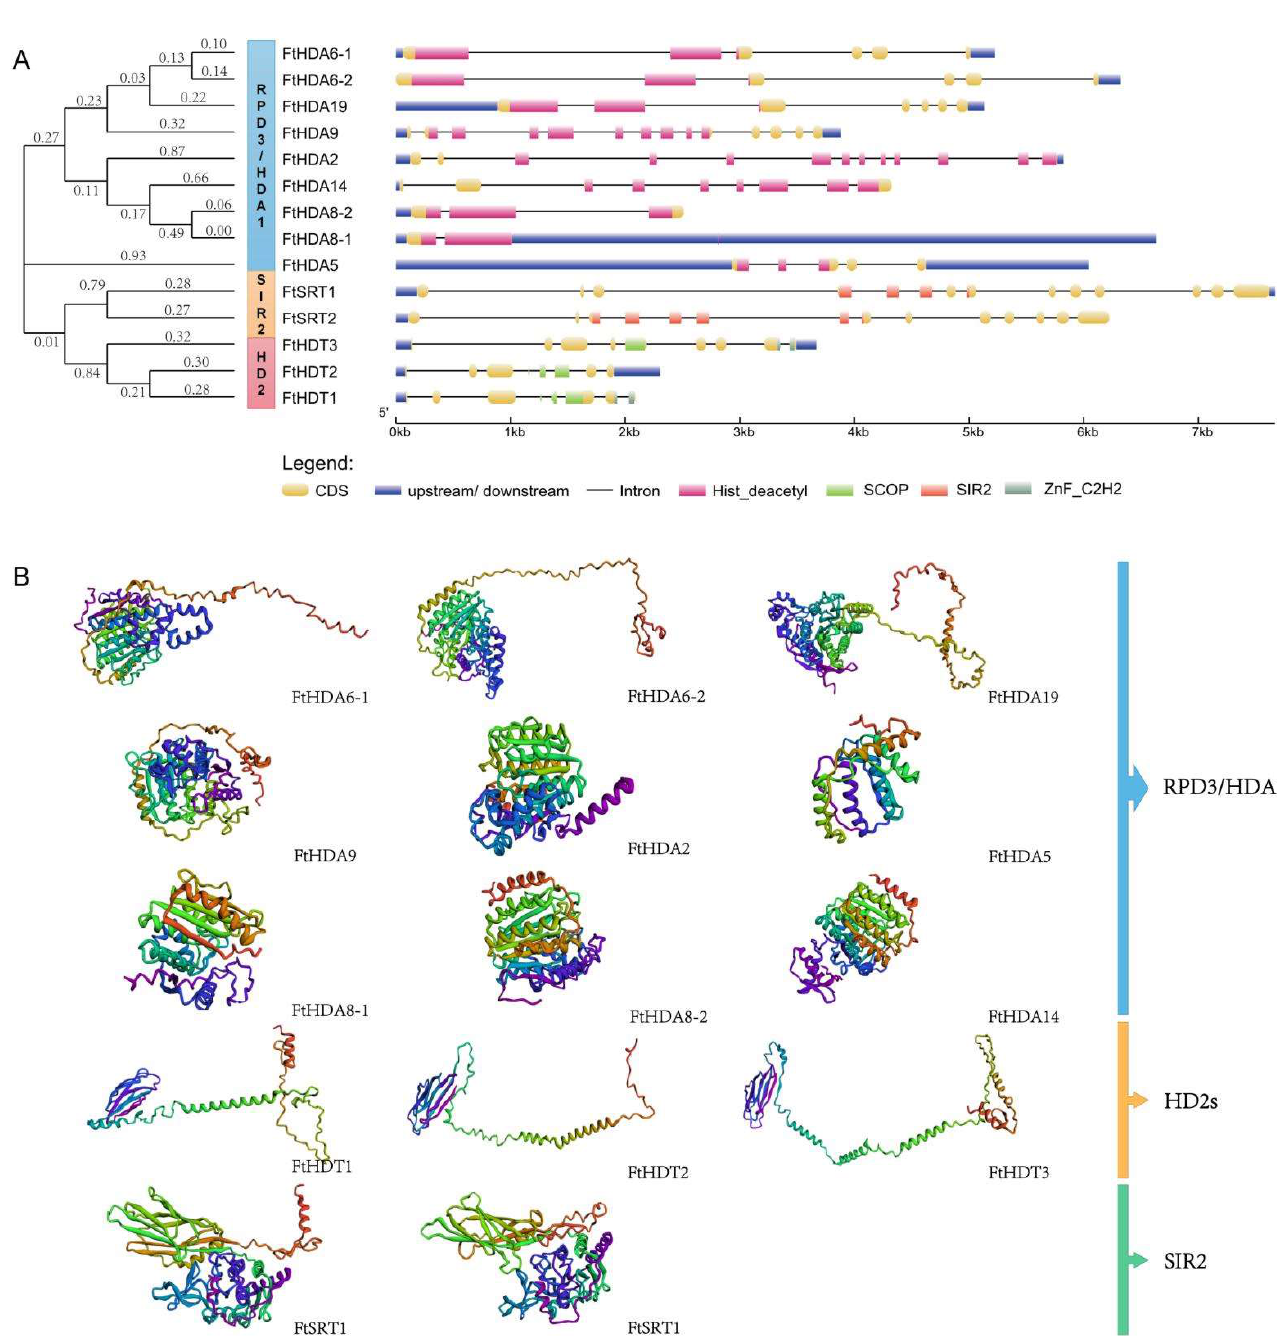
Figure 1. Phylogenetic relationships, motif structure and three-dimensional protein structure of FtHDACs. ( A ) Phylogenetic relationships and exon/intron structures of FtHDAC genes. The different structural units are represented by different colors, respectively. ( B ) Models and ribbon diagrams show the 3D domain structure of 14 FtHDACs proteins. Blue to red, N- to C-terminus.